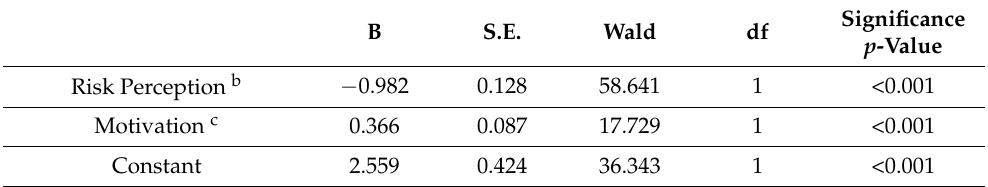
Table 2. Logistic Regression of Motivation and Risk Perception on Vaccination Hesitancy a